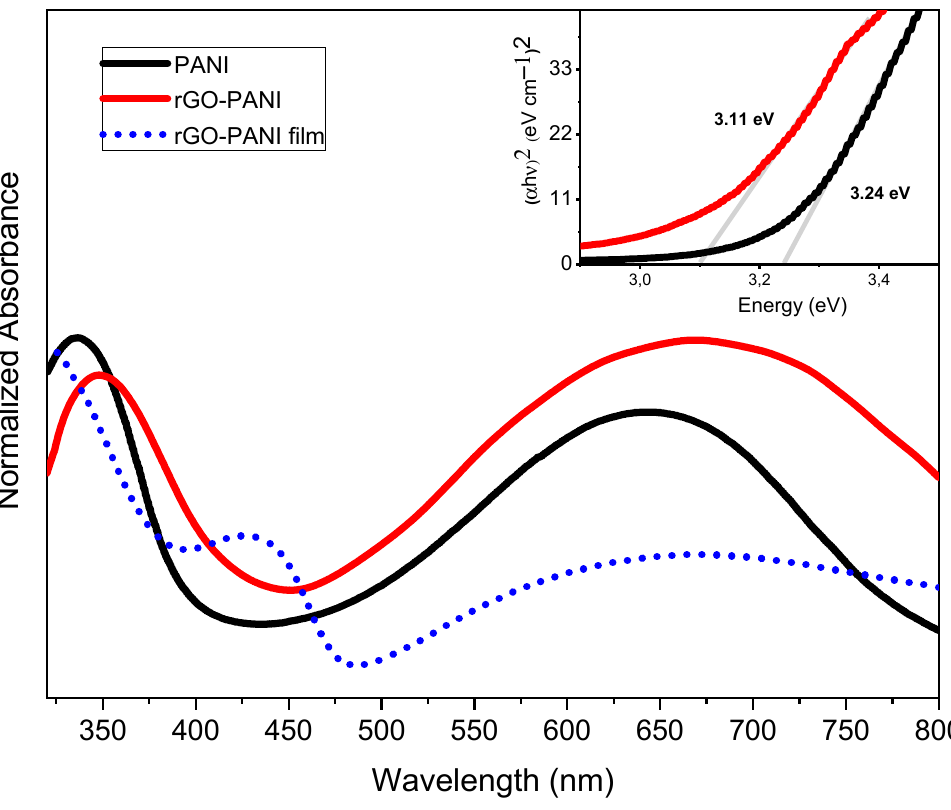
Figure 4. UV-vis spectra acquired from PANI (solution) and rGO-PANI (suspension and film). Inset: Tauc plots for PANI and rGO-PANI (suspensions).